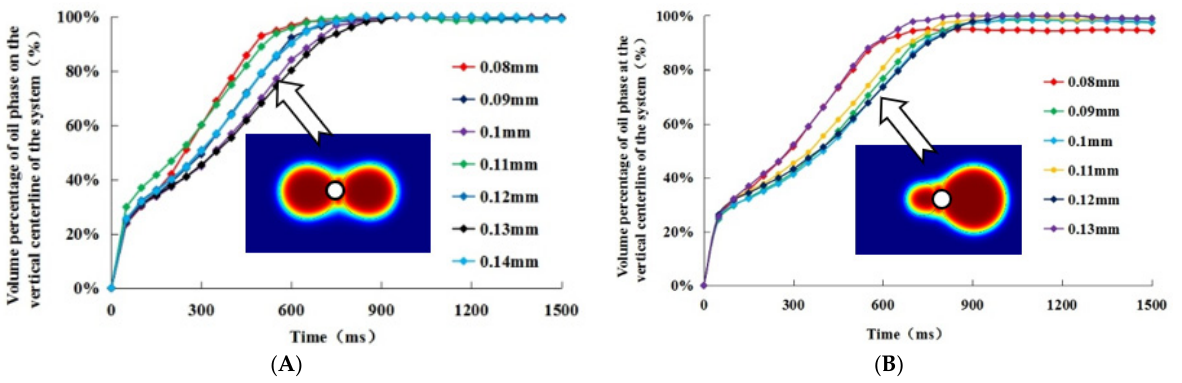
Figure 5. Saturation change in the central line during the coalescence of two oil droplets. ( A ) Saturation change in the central line during the coalescence of two oil droplets of the same size. ( B ) Saturation change in the central line during the coalescence of two oil droplets of the different sizes.